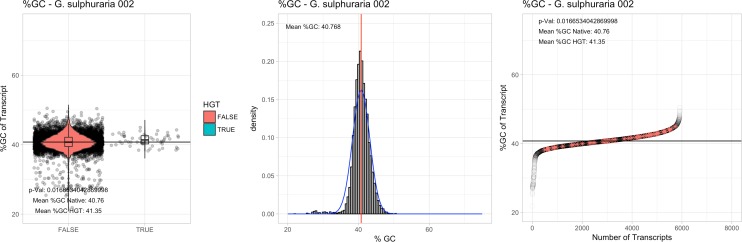
%GC – Galdieria sulphuraria 002: (Left) Violin plot showing the %GC distribution across native transcripts and HGT candidates.(Mid) Cumulative %GC distribution of transcripts. Red line shows the average, blue line a normal distribution based on the average value. (Right) Ranking all transcripts based upon their %GC content. Red ‘*' demarks HGT candidates. As the %GC content was normally distributed, students test was applied for the determination of significant differences between the native gene and the HGT candidate subset.